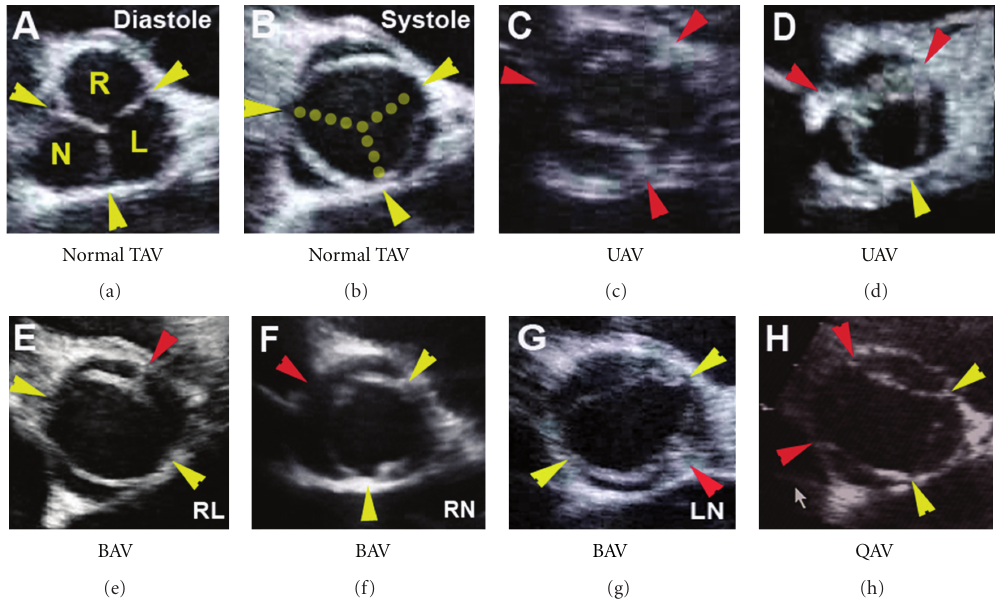
Figure 1: Spectrum of aortic valve malformation. Parasternal short-axis echocardiographic views at the base of the heart showing the aortic valve en face (a–h). Normal tricommissural aortic valve (TAV) morphology is demonstrated in diastole (a) and systole (b). Distinct morphologies are based on fusion patterns of the commissures (dotted lines, (b)) as they relate to the right (R), left (L), and non-(N) coronary sinuses of Valsalva (a). Aortic valve malformation ranges from unicuspid (UAV) to bicuspid (BAV) to a thickened tricuspid (not shown) to quadricuspid (QAV) morphology. Three normal commissures are demonstrated in (a), and normal opening of the commissures results in complete cusp separation to the wall of the aorta at the sinotubular junction (yellow arrowheads). UAV manifests as either partial fusion of all three commissures (red arrowheads, (c)) or complete fusion of both the RN and RL commissures (d). Bicuspid aortic valve (BAV) may manifest as fusion of the RL (e), RN (f), and rarely LN (g) commissures. Rarely, a quadricuspid aortic valve (QAV, (h)) is